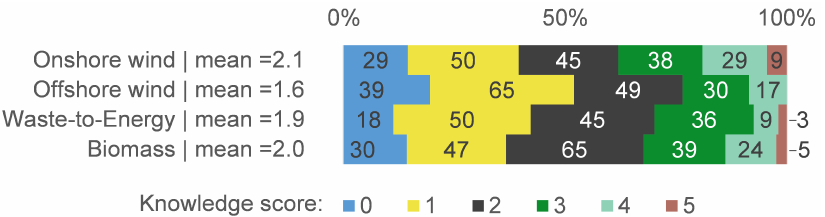
Figure 2. Knowledge score based on the number of correct estimations regarding the share of different energy carriers in the Belgian electricity mix of participants. Distribution among the participants in % per survey